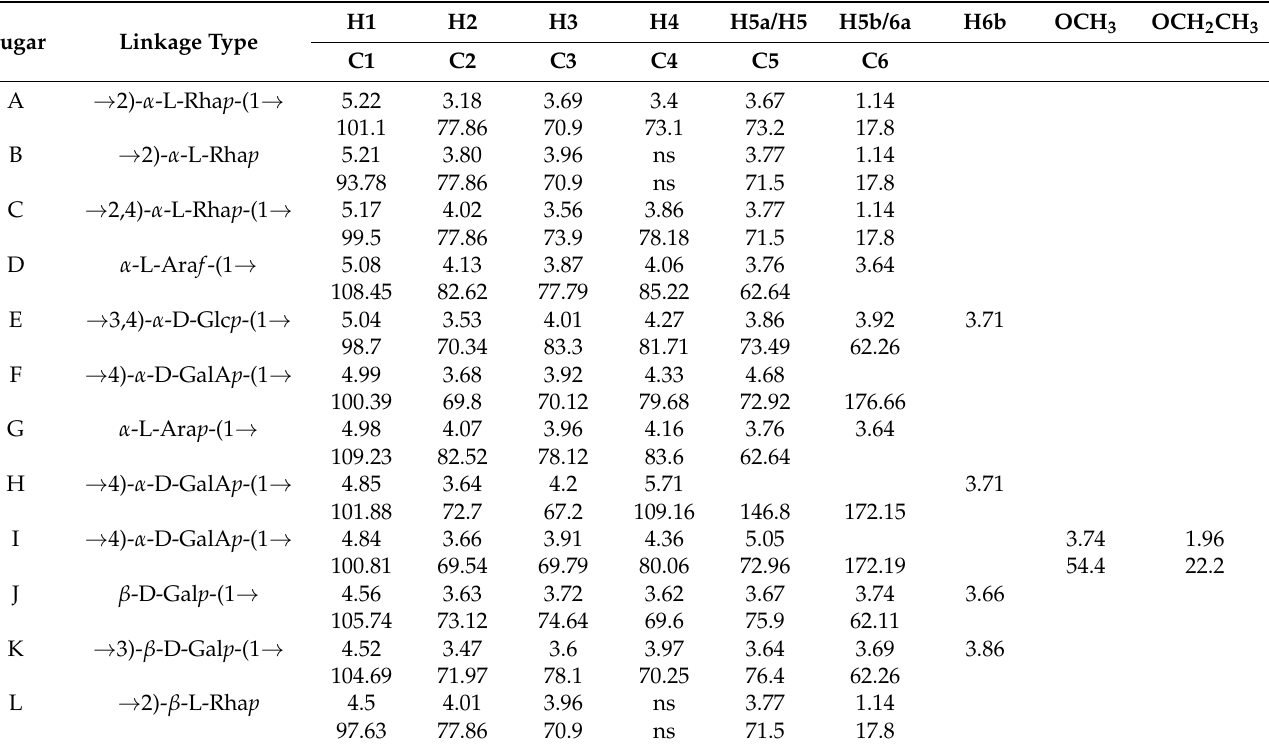
Table 2. Assignment of 1 H and 13 C NMR chemical shift values of RPP-2a.